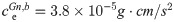
Patterns of glioma infiltration in different intra- and extra-cellular microenvironment.(A) Different patterns of two migratory glioma cells at final time t = 60 min for various distances between two astrocytes (d = 3, 4, 5, 6 μm) and different nuclear stiffness (fold) of a glioma cell located in the center. The default parameter value of the elastic stiffness of nucleus is ceGn,b=3.8×10-5g·cm/s2. (B,C) A migration profile and stiffening rate (r[mb]) of two migratory glioma cells at time t = 0, 20, 40, 60 mins when d = 4μm and nuclear stiffness is a fold-change of 1 for the migratory glioma cell in the center. The default parameter value was used for the glioma cell on the left.